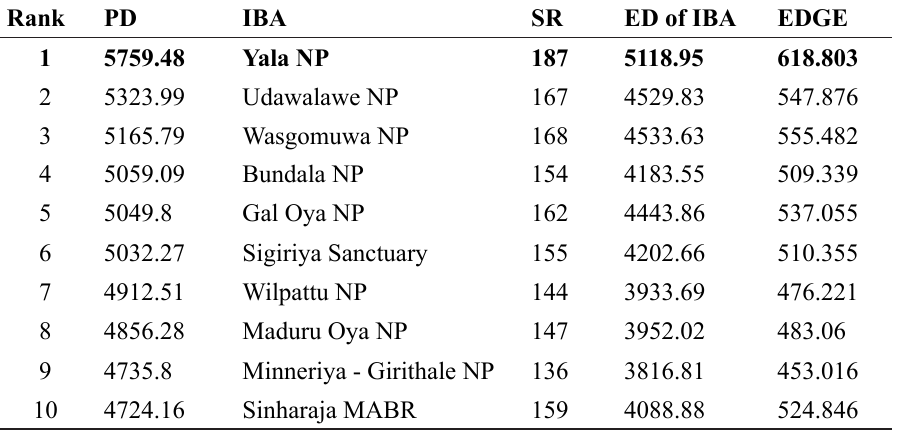
Table 04: Top 10 IBAs with highest phylogenetic diversity (PD). Only resident species of birds were included for this analysis.